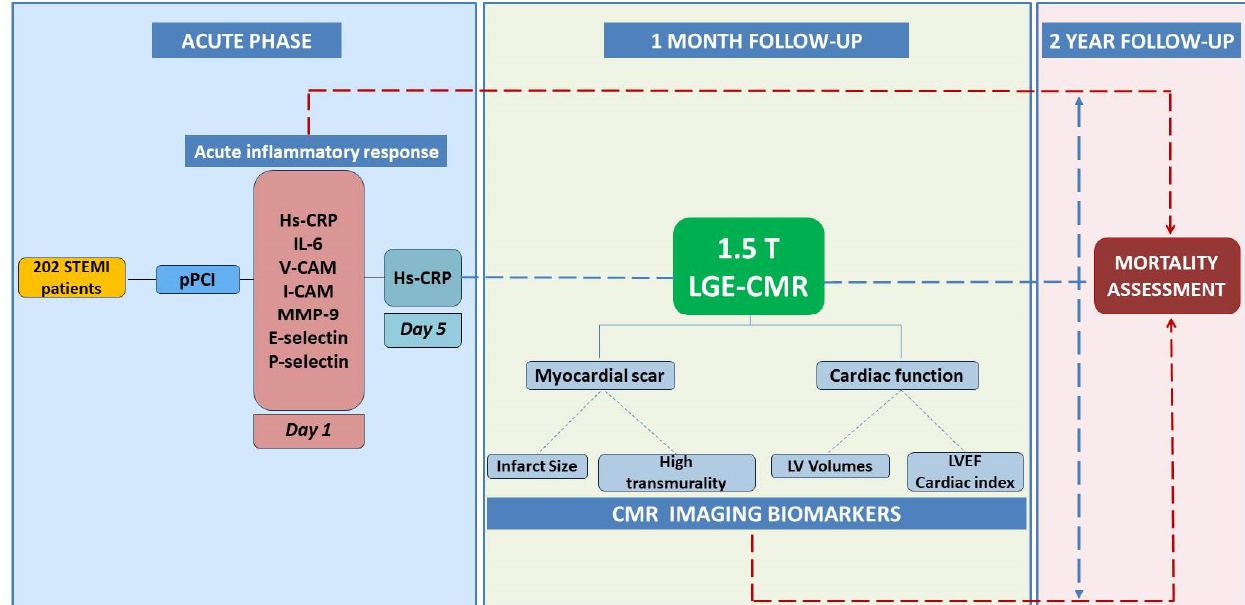
Figure 1. Flowchart of the study design and procedures.